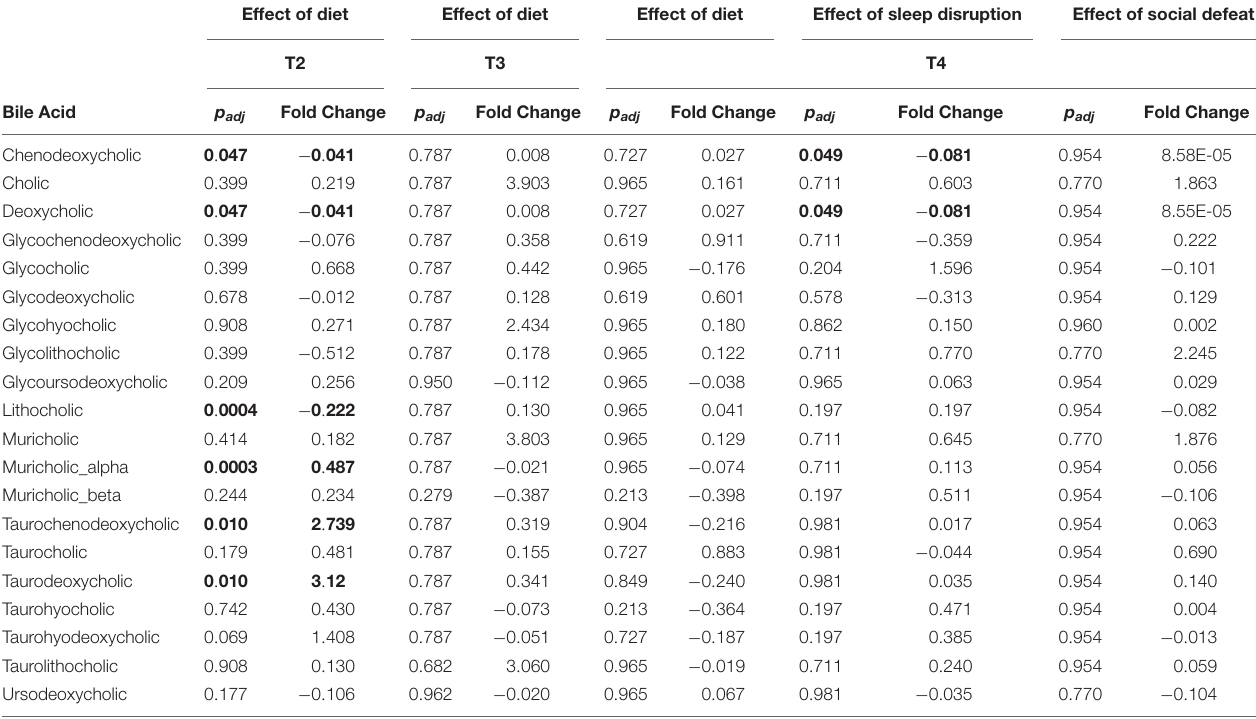
TABLE 1 | Fecal bile acids across the experiment. Effect of diet Effect of diet Effect of